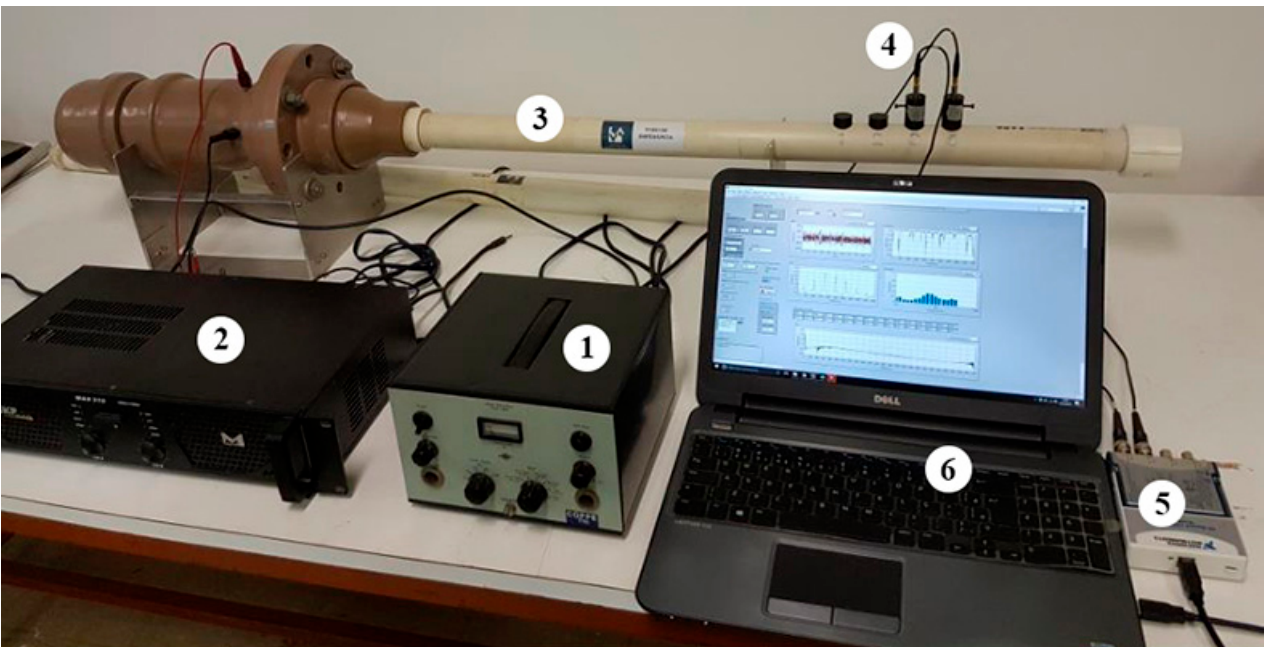
Figure 5. Sound absorption test assembly and equipment: 1—Signal generator (B&K 1405), 2—Power Amplifier (SKP MAX 310), 3—Impedance Tube (LAVI/UFRJ), 4—Microphones (BSWA MPA416 1/4”), 5—Signal Processor Board (NI 9234) and 6—Processing Software (LabVIEW).